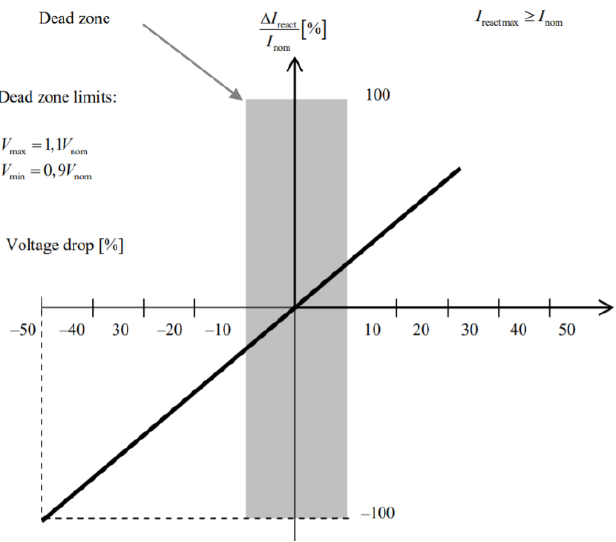
Figure 4. Reactive Current Injection Requirements.